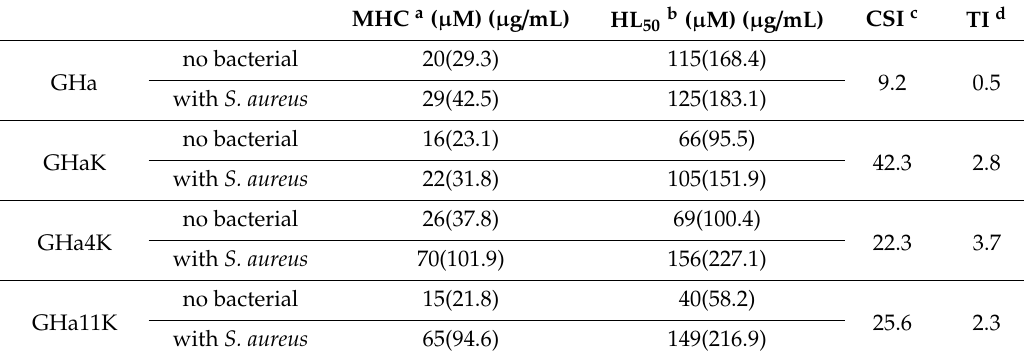
Table 4. Hemolytic activity of GHa and derived